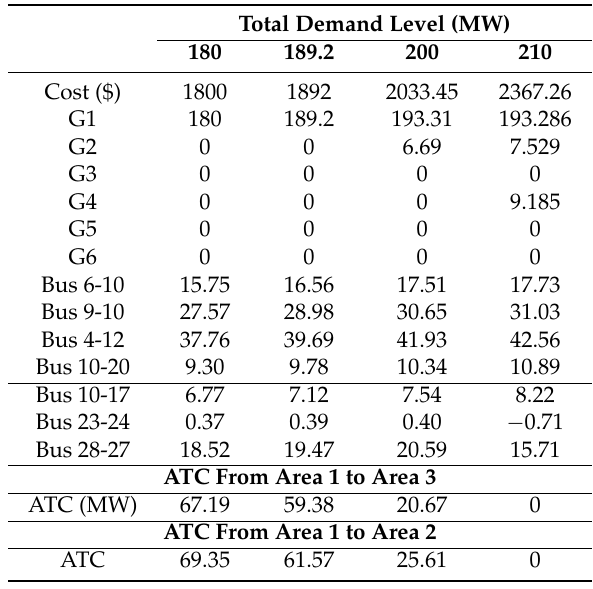
Table 5. ATC and ED results of IEEE 30-bus system under different demand